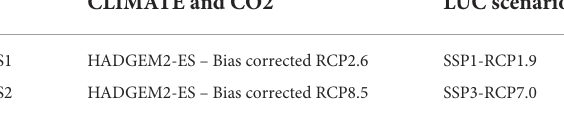
TABLE 1 Configuration of the simulations. CLIMATE and CO2 LUC